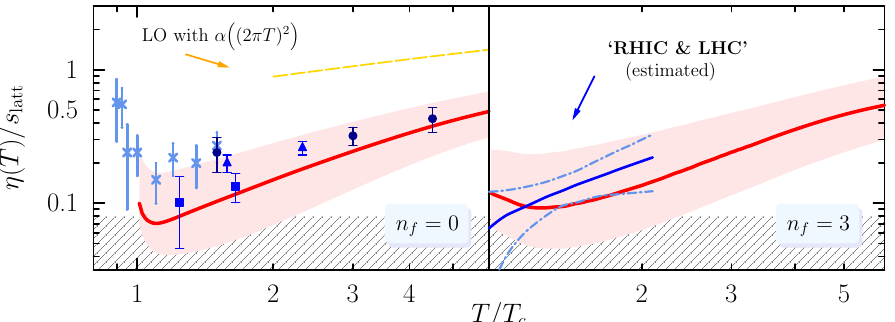
Figure 2. The viscosity in units of the entropy [7]; full lines show our result with running coupling, the bands give the uncertainty from t (cid:63) ∈ [ 1 ,2 ] T 2 , see text. The left panel, for the quenched limit, 2 shows lattice results [3], and by the dashed line the LO result with Q T = 2 π T in running coupling. Overlayed on the right, for n f = 3, are estimates from hydrodynamics [11]. Hatched region: η / s ≤ 1/ ( 4 π )